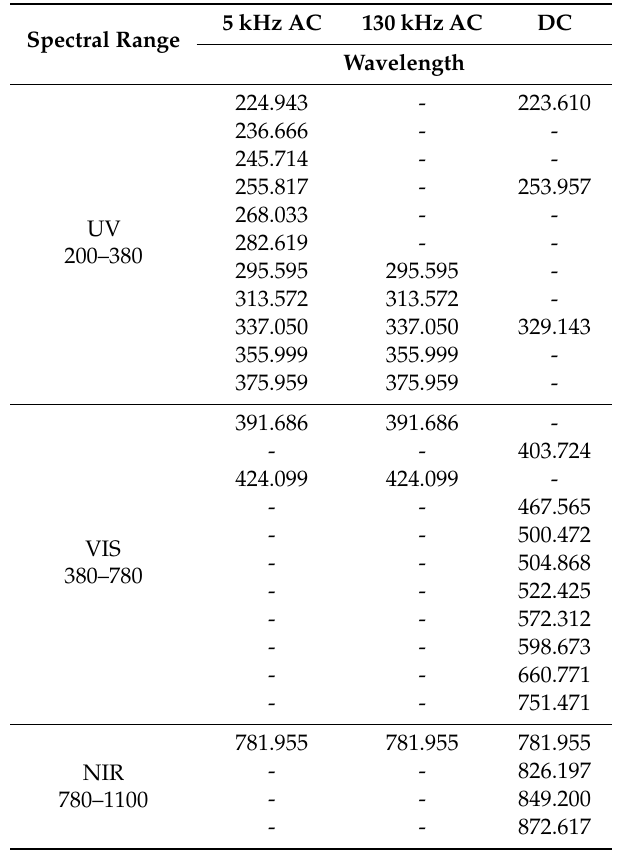
Table 1. Characteristic peaks from electromagnetic spectrum from